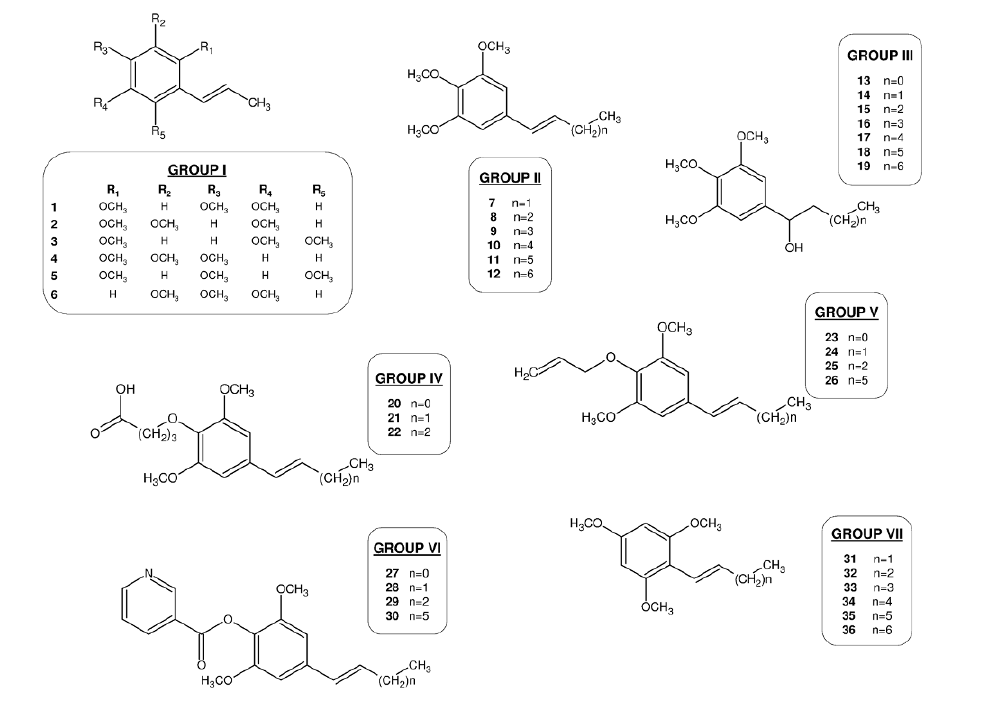
Figure 1. Structures of tested